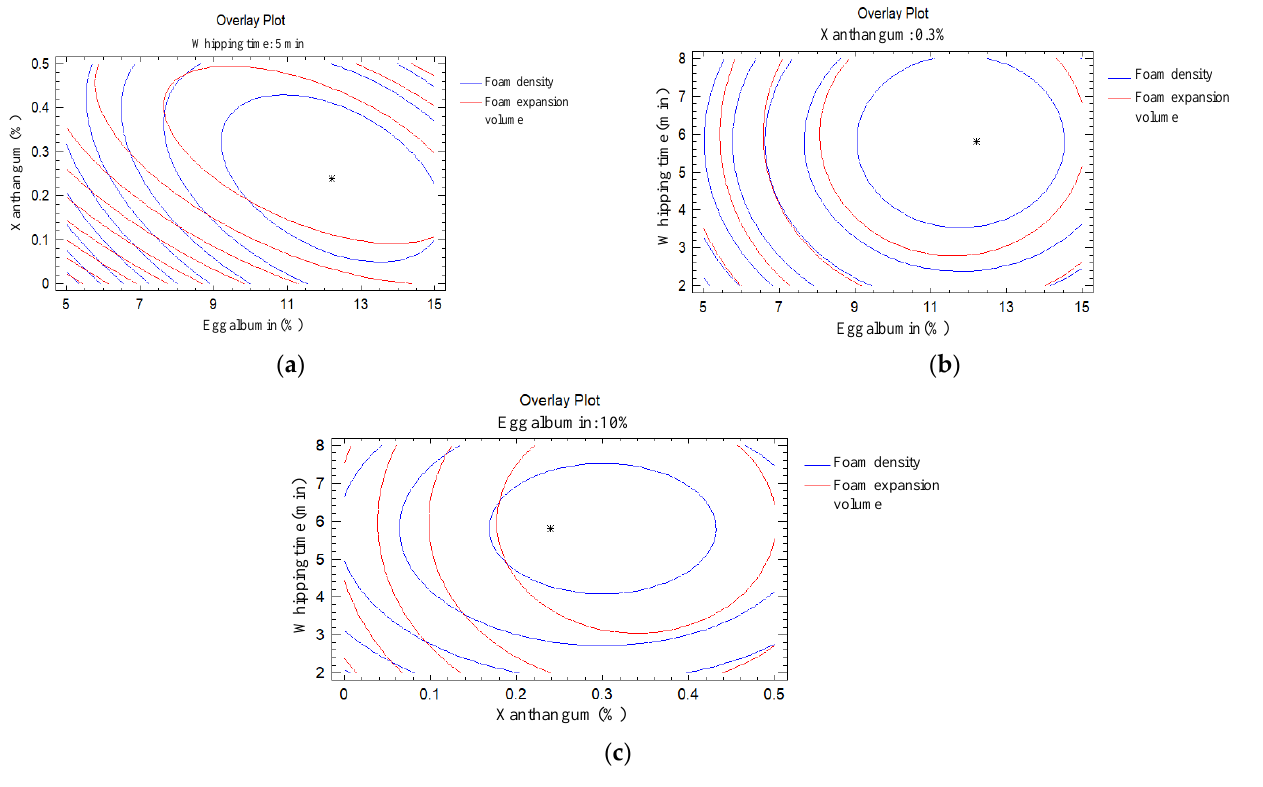
Figure 3. The overlay plot of foam density and foam expansion volume of magenta leaves extract and optimum value* (different levels of input variables). ( a ) Whipping time 5 min; ( b ) Xanthan gum 0.3%; and ( c ) Egg albumin 10%. Table 5. Predicted and actual value of responses from optimal conditions.